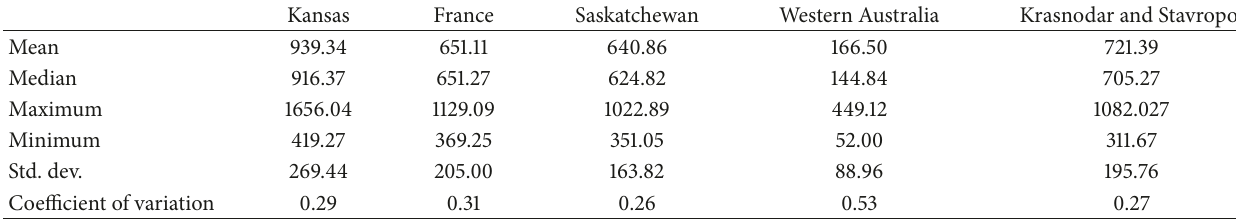
Table 3: Summary of precipitation statistics (mm).